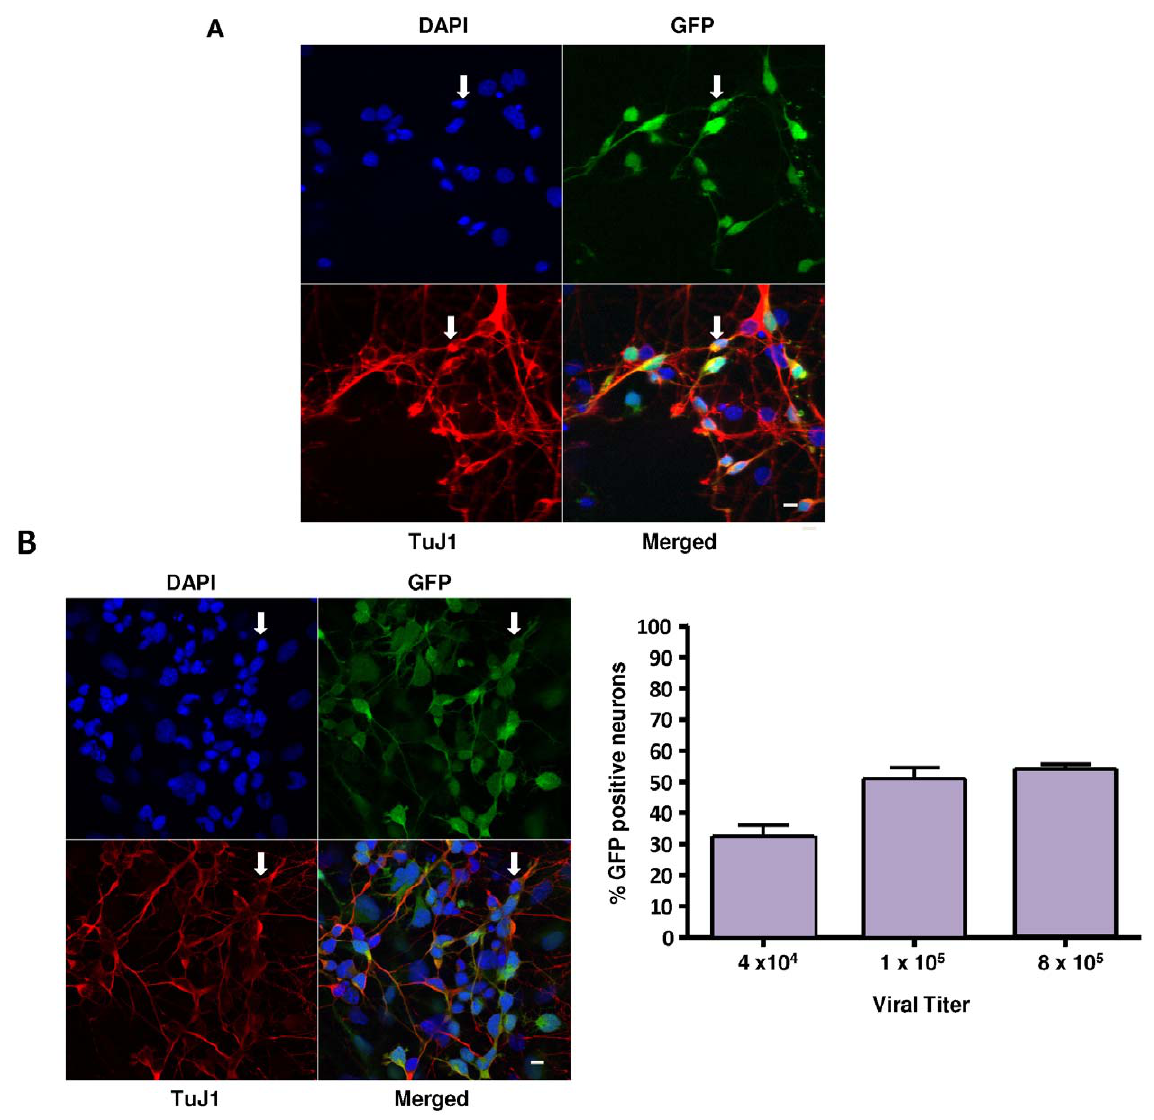
Figure 9. Rat cerebral cortical neurons are susceptible to infection by the gammaretrovirus, AZE-GFP, as well as RT43.2GFP gammaretroviral vectors. A . Cortical neurons were cultured from rat embryo brains at day 18 for seven days in vitro and then exposed to AZE-GFP in the presence of 1 m g/ml polybrene. Polybrene and virus were removed after 18 hours and cells immunostained with anti-GFP and TuJ1 antibodies, followed by DAPI staining, five days post-AZE-GFP exposure, and photographed at 63 6 with a laser scanning confocal microscope. Arrows indicate GFP-positive TuJ1 positive cells. Scale bar=3 m m. B . Panel of representative confocal micrographs (left) of rat cerebral cortical neurons 5 days after exposure to RT43.2GFP vectors. Cells were immunostained with anti-GFP antibody and TuJ1 antibodies, followed by DAPI staining. The lower right hand quadrant of the panel shows the merged staining. Arrows indicate GFP positive, TuJ1 positive neurons. Scale bar=3 m m. Graph of transduction efficiency (right) shows percentage of GFP-positive cells compared to total TuJ1 positive cells after exposure to 4 6 10 4 , 1 6 10 5 , and 8 6 10 5 viral particles. doi:10.1371/journal.pone.0018072.g009 three plasmids: 10 m g pRRL-SIN-18, 6.5 m g pMoMLVgagpol and (PBS) to obtain a 500-fold concentrated retroviral stock, and aliquots were stored at 2 80 u C. For LNCX-HDHBc-tdimer2 3.5 m g pVSV-G. After collecting viral supernatants, the vectors vectors, 293T cells were transfected with 10 m g pLNCX-HDHBc- were concentrated to a 500-fold stock as mentioned above. The titer of concentrated vector particles was determined by transduc- tdimer2, together with 5 m g pVSV-G and 2.5 m g pMuLVgagpol. ing MDTF cells with serial dilutions of retroviral stock as follows: 48 hours after transfection, the supernatant was concentrated 16- MDTF cells were seeded at a density of 2.0 6 10 4 cells per well in a fold over Amicon 100,000 MW cut-off filters (Millipore, Billerica, MA). Gammaretroviral vectors were produced by transient 24-well plate and transduced 6 hours later. Sixteen hours after transfection of 293T cells using a three-plasmid system: 10 m g transduction, medium was changed. GFP-positive cells were counted 48 hours after transduction, and retroviral titer was pRT43.2GFP or pRT43.2GFPBcl-xL plasmid, 2.5 m g MoMLV obtained by dividing the number of GFP-positive cells by the gagpol plasmid, and 5 m g VSV-G envelope plasmid. Lentiviral volume of vector particles. vectors were produced by transiently transfecting 293T cells with